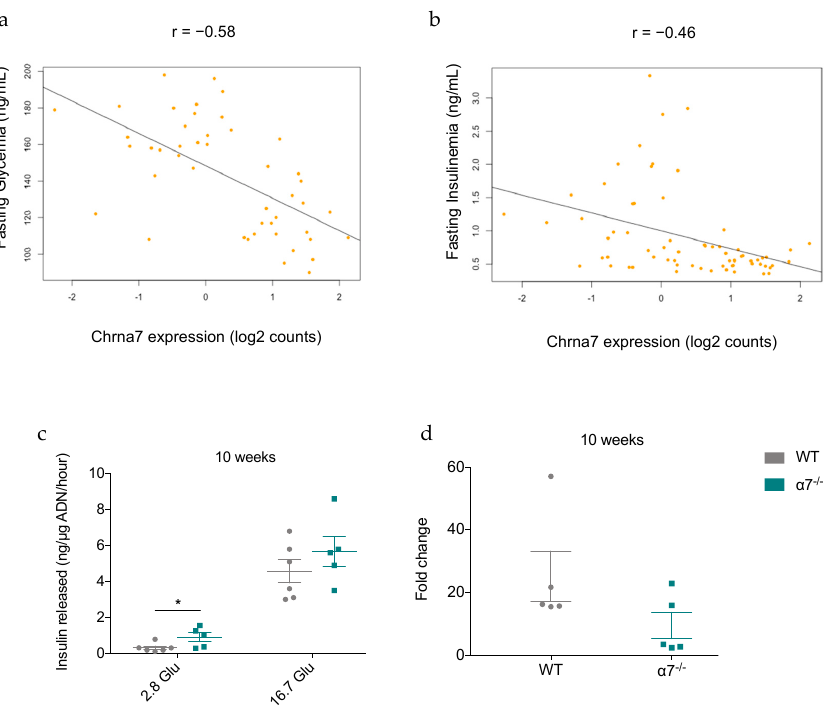
Figure 8. Correlation between the expression of α 7 nAChR in mouse islets and fasting glycemia and insulinemia. Scatter plots showing that chrna7 gene expression, encoding for the α 7 nicotinic subunit, from islets is negatively correlated with fasting glycemia ( a ); Spearman’s r = − 0.58, p -value = 1.7 × 10 − 5 (all samples) and with fasting insulinemia ( b ); Spearman’s r = − 0.46, p value = 0.001 (all samples). Glucose-induced insulin secretion was measured in isolated islets from 10-week-old α 7 − / − and WT control mice ( c ). Insulin released at 2.8 mM and 16.7 mM glucose was determined as described in Experimental procedures. The fold change in insulin secretion in response to 16.7 mM glucose was measured after 1-h static incubations ( d ). Each dot represents a mouse (grey dots for WT mice and green squares for α 7 − / − mice). All data are presented as mean ± SEM. Symbol * indicates a significant di ff erence compared to control WT using unpaired Mann–Whitney two tailed test ( c , d , n = 5–6 / group, * p < 0.05). 2.8Glu: 2.8 mM glucose; 16.7Glu: 16.7 mM